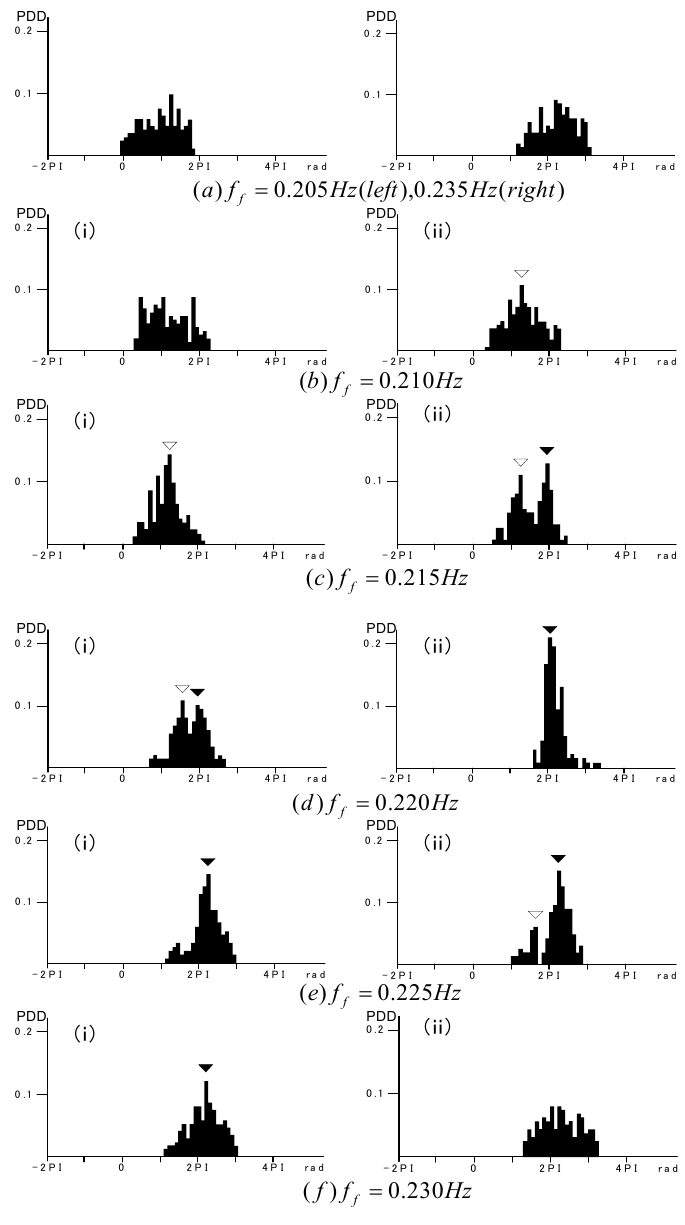
Fig.3 Probability density distributions of phase